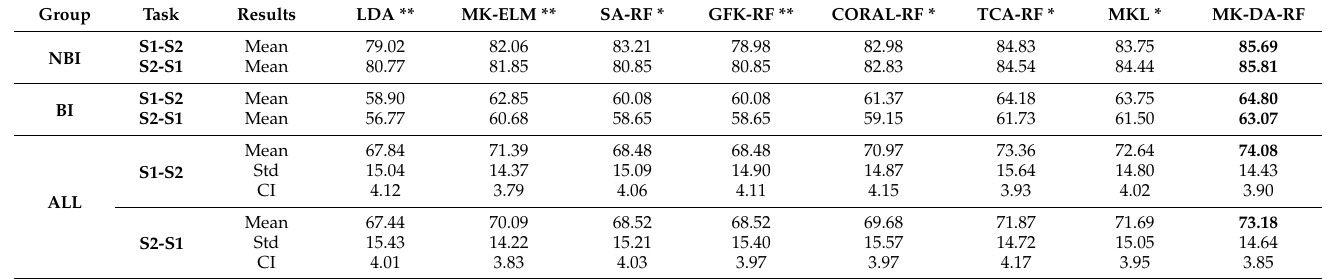
Table 3. A comparison of the different distribution adaptation methods for the source and target data from different sessions.